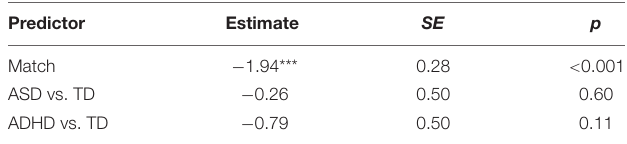
TABLE 3 | Estimated effects for Clinical group and Match on accuracy in object pronoun interpretation.